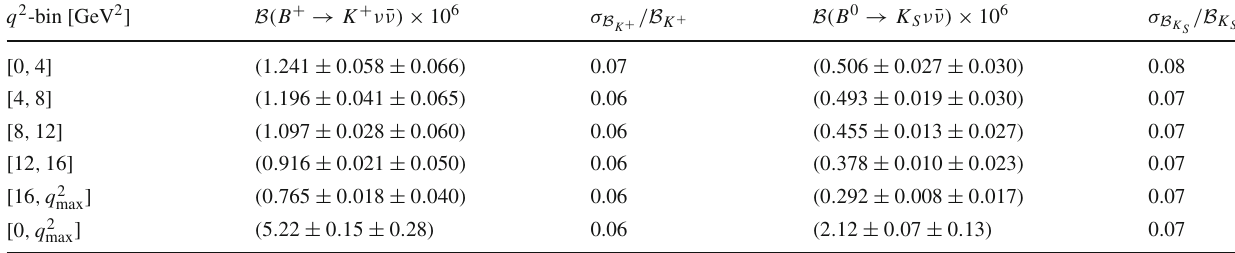
Table 3 SM predictions for the partially integrated B → K ν ¯ ν branch- ing fraction, in a given q 2 -bin, obtained by using our fit to the lattice form factors from HQPCD [33] and FNAL/MILC [34], and the CKM input | λ t | = 4 . 00 ( 10 ) × 10 − 2 . The first uncertainty comes from the